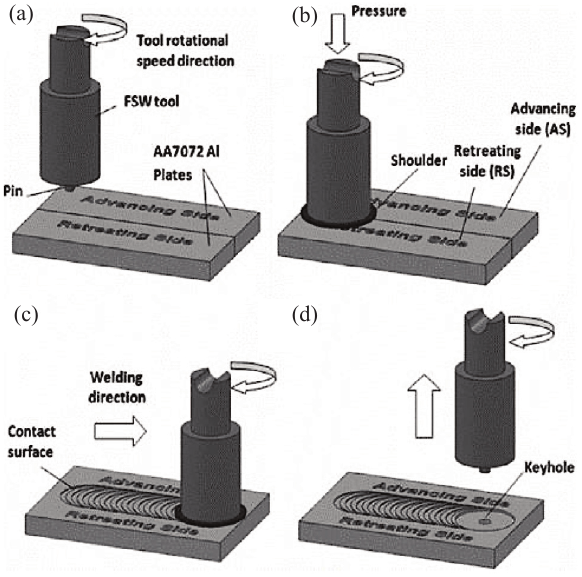
Fig. 1. Presentation of the different steps of the FSW process: